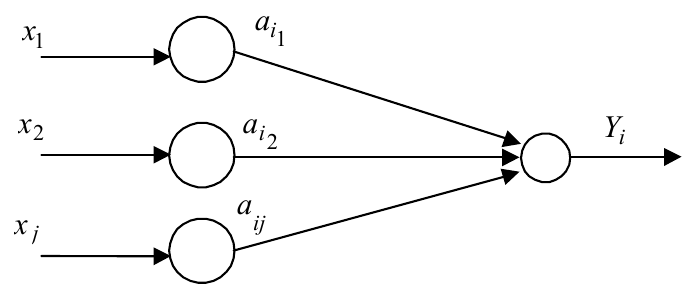
Fig 2. Neural network structure for multiple linear regression